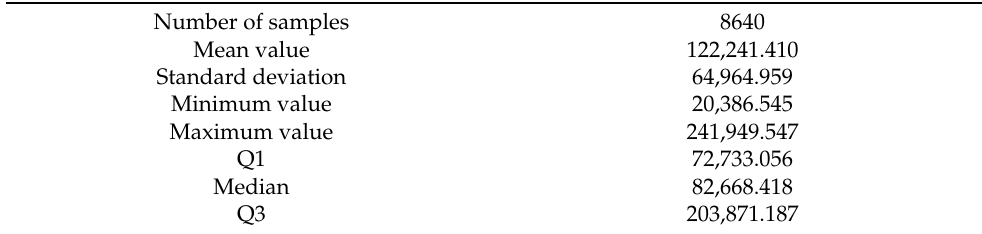
Table 2. Basic characteristics of the